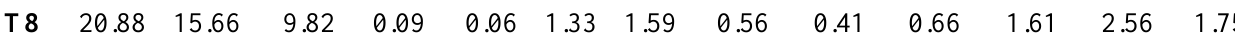
Coordination, Subordination and Phrasal Complexity based on T-units